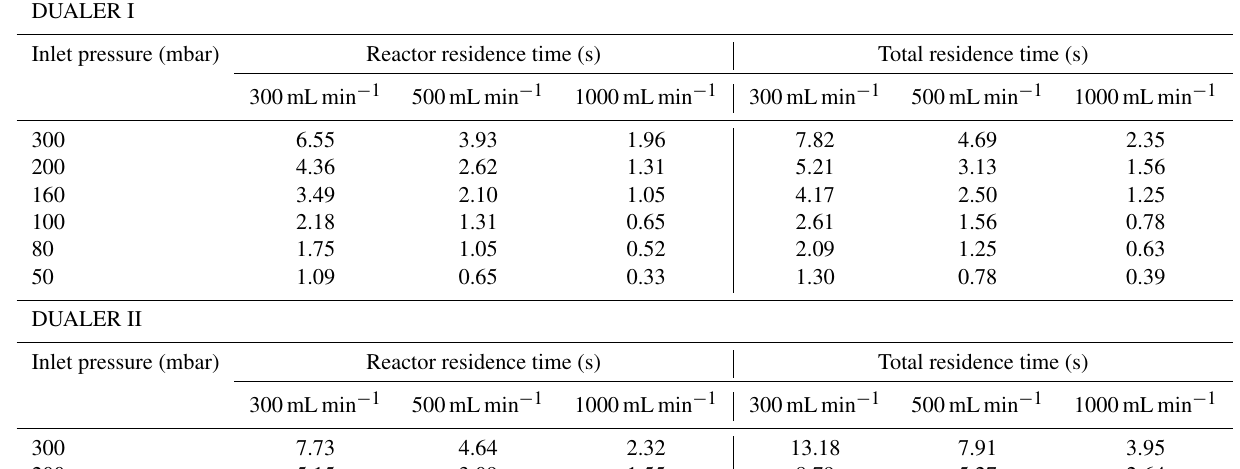
Table 3. Sample residence times in PeRCEAS for different operating total flows and pressures. Reactor residence time: residence time between the first and the second addition points in each reactor; total residence time: residence time between the first addition point in each reactor and the corresponding detector. The inner volumes up to the detector are 132cm 3 in DUALER I and 220cm 3 in DUALER II. DUALER I